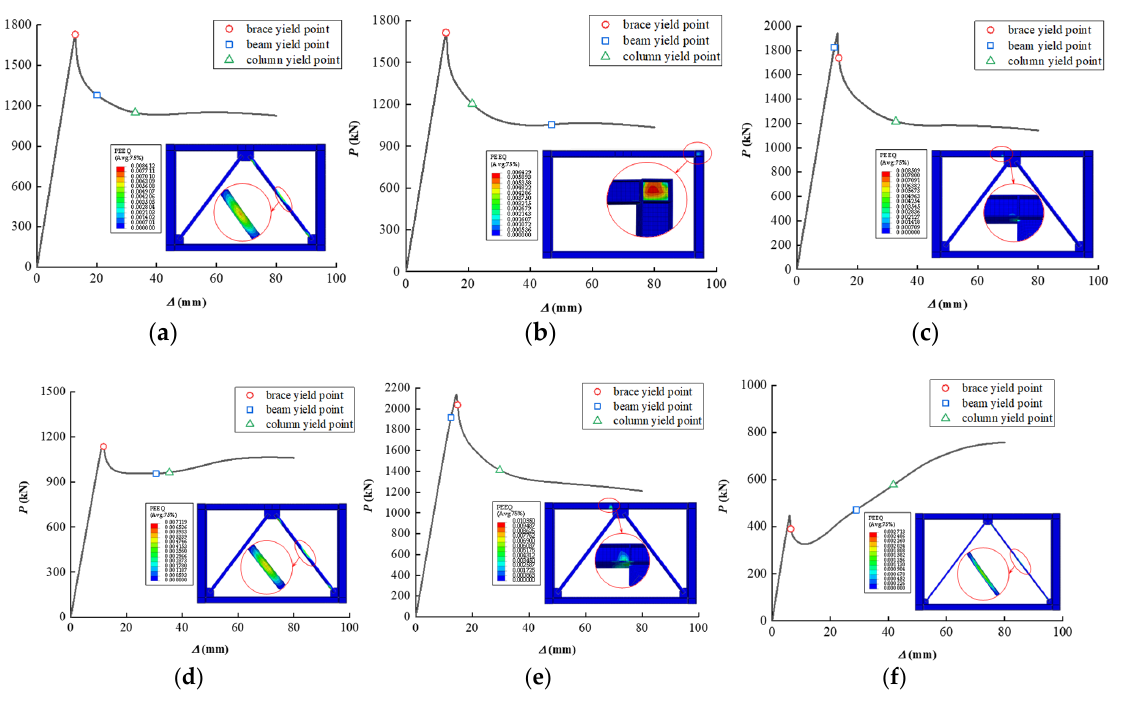
Figure A1. The predicted PEEQ distributions of top floor concentrically ‐ braced steel frames ( η = 0.15). ( a ) case 13, the basic model obtained by the proposed method; ( b ) case 16, smaller section area of column web; ( c ) case 19, thicker braces; ( d ) case 22, thinner braces; ( e ) case 25, larger brace external